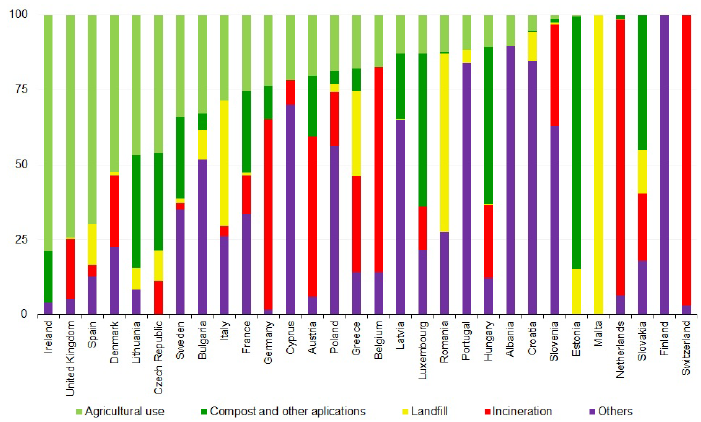
Figure 1. Sewage sludge management in European countries in 2017 (Updated data by Eurostat,